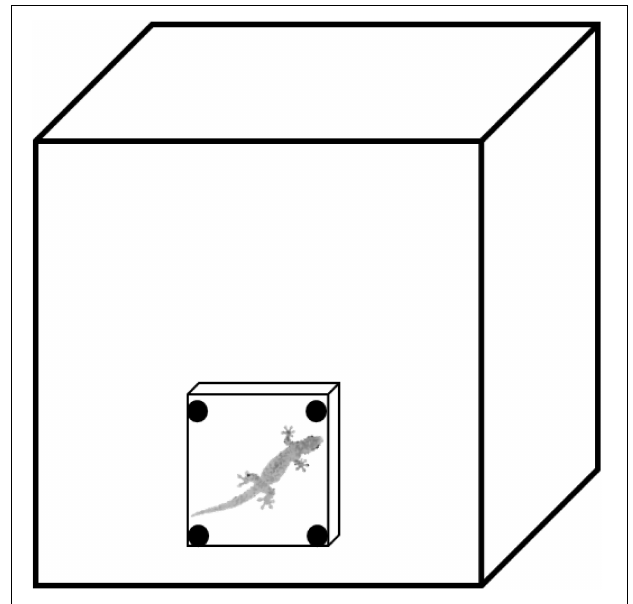
FIGURE 3 | Experimental testing arena to test emergence time of Gehyra dubia in the laboratory. Testing arenas (glass terraria: 500 × 400 × 300 mm; L × W × H) have a ceramic tile shelter (100 × 100 × 150 mm; L × W × H) adhered to one vertical wall of the terrarium with BluTack adhesive (Blu-Tack, Bostik Australia Pty Ltd., Thomastown, VIC, Australia). Figure adapted from Nordberg et al.,